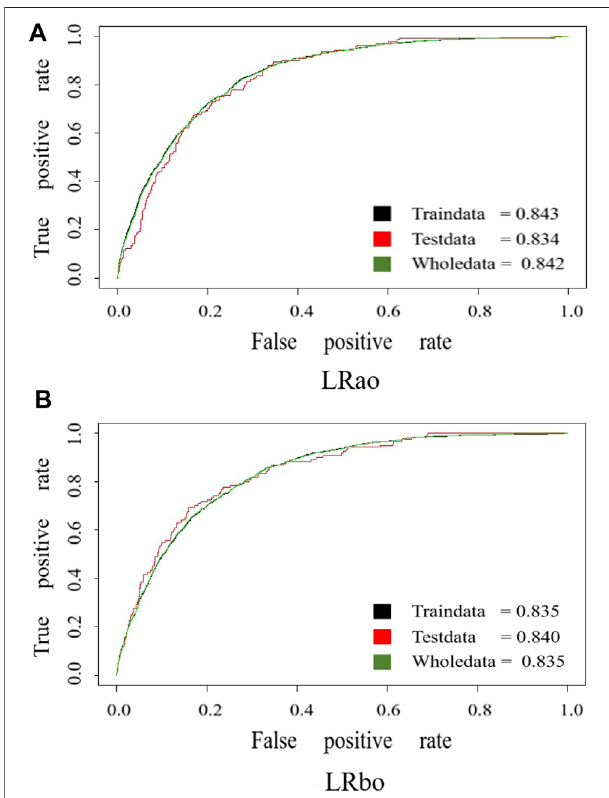
FIGURE 5 | ROC curve of the LR ao and the LR bo